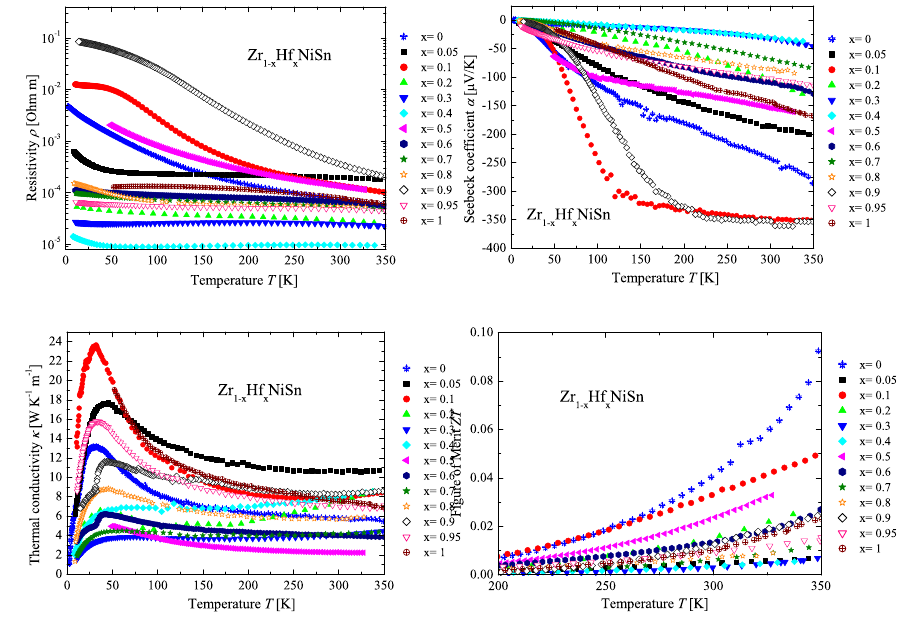
Figure 3. Electrical resistivity ( top left ), Seebeck coefficient ( top right ), thermal conductivity ( bottom left ) and figure of merit ( bottom right ) of the Zr ( 1 − x ) Hf x NiSn series in comparison to the parent